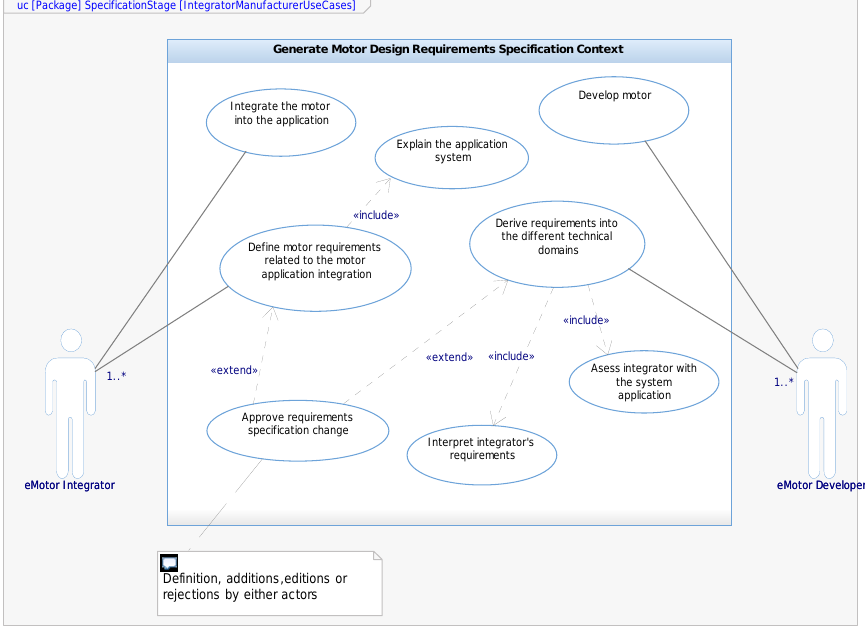
Figure 2 . Use case diagram of stakeholders in the specification context. Figure 2. Use case diagram of stakeholders in the specification